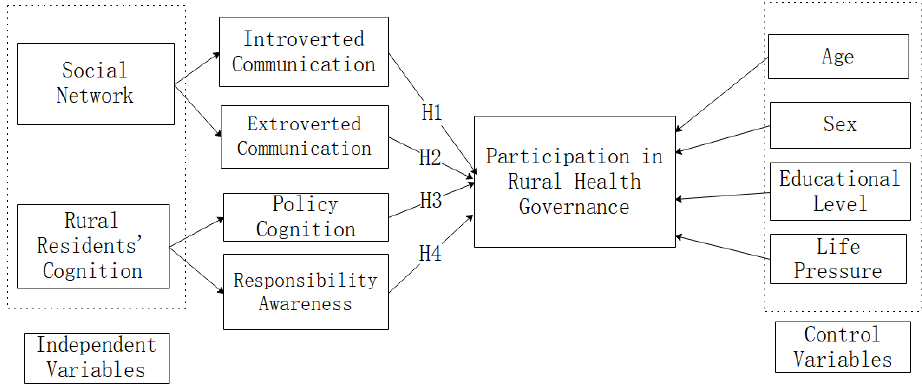
Figure 1. Conceptual